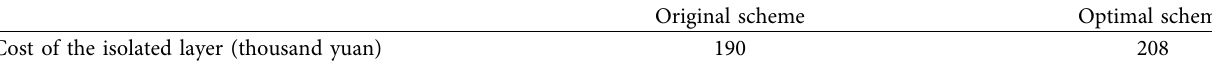
Table 3: Cost of the isolated layer in the optimal and original scheme.